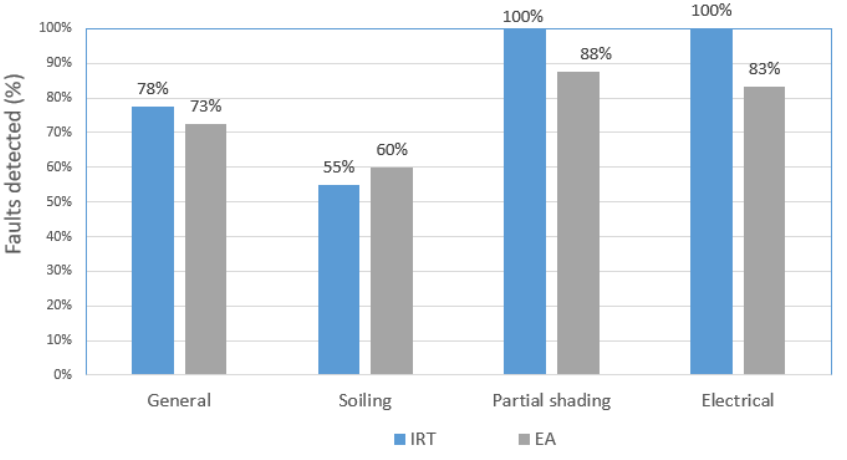
Figure 13. Percentage of failures detected by IRT and EA for the three types of failures analyzed in this